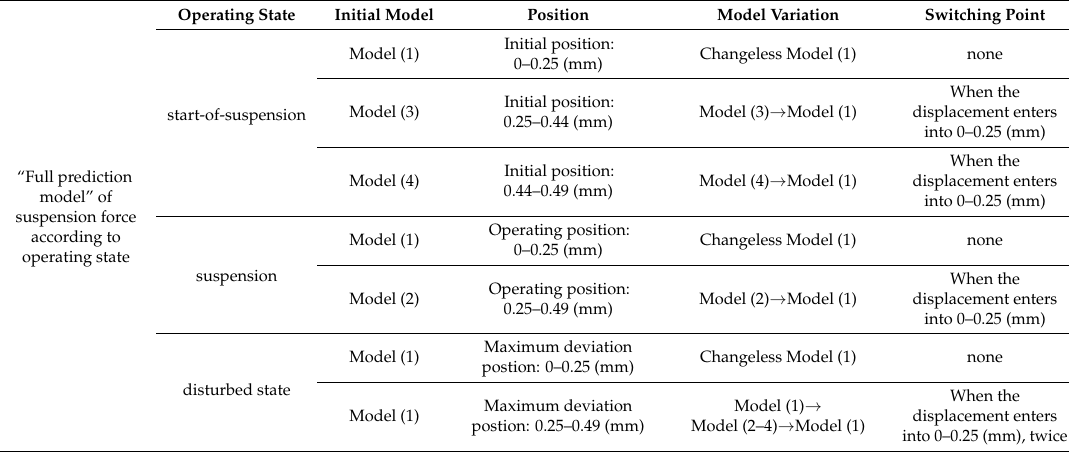
Table 2. The “full prediction model” of suspension force according to operating state selection